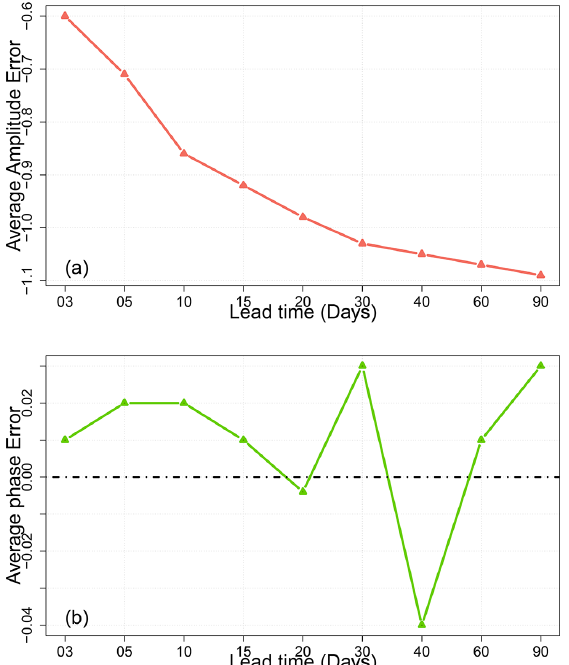
Figure 11. The average amplitude error ( E A ) and average phase error ( E φ ) of the MJO over all seasons for the period from 1979 to 2020. We note that the amplitude is underestimated, and the phase is well predicted by comparing predictions to forecasts.